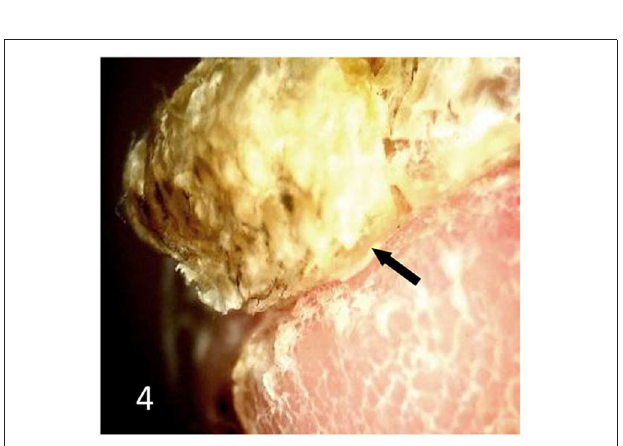
FIGURE 4 | Subungualhyperkeratosis and debris.